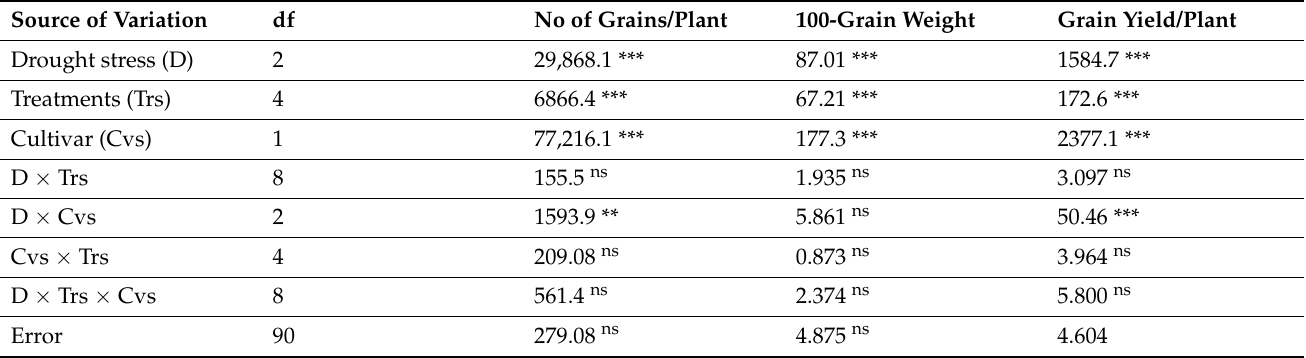
Table 3. Analyses of variance data for yield attributes of maize ( Zea mays L.) cultivars subjected to varying levels of sugar beet extract (SBE) and glycine betaine under water deficit